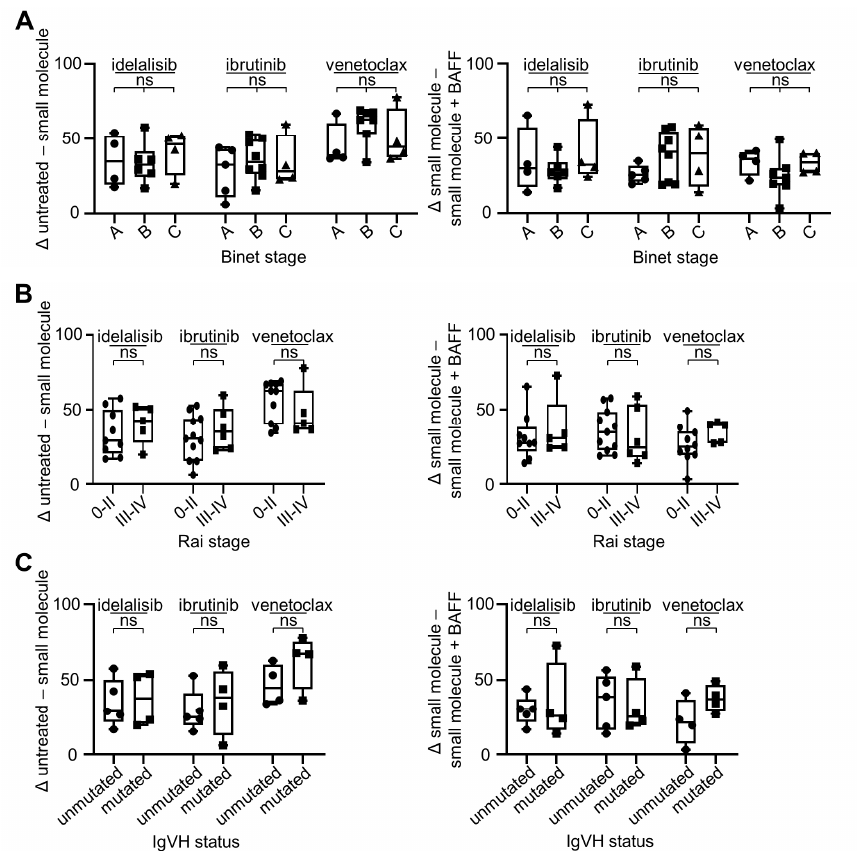
Figure 2. Clinical Binet stage, Rai stage and IgVH mutational status do not impact response to small molecule inhibitor treatment or survival-promoting effects of BAFF . PBMC from different CLL patients were exposed to idelalisib (500 nM), ibrutinib (500 nM) or venetoclax (2 nM) in the presence or absence of rhBAFF (500 ng/mL) and cell viability was determined by CTG assays. Results were normalized to the respective untreated samples and relative viability was calculated. The difference between the untreated sample and the small molecule inhibitor-treated sample (left side) and the difference between the respective small molecule inhibitor-treated sample alone and in combination with rhBAFF (right side) were analyzed. Results are depicted according to the clinical Binet stage ( A ), Rai stage ( B ) and IgVH mutational status ( C ). For statistical analyses, ordinary one-way ANOVA with Tukey’s multiple comparisons tests were performed in ( A , left) for idelalisib (A vs. B p = 0.9766, A vs. C p = 0.8850, B vs. C p = 0.7557) and ibrutinib (A vs. B p = 0.7739, A vs. C p = 0.5810, B vs. C p = 0.9138), and a Kruskal-Wallis test with Dunn’s multiple comparisons test for venetoclax (A vs. B p = 0.8564, A vs. C p = 0.9279, B vs. C p > 0.9999) (idelalisib: Binet A n = 4, Binet B n = 5, Binet C n = 5; ibrutinib: Binet A n = 5, Binet B n = 7, Binet C n = 5; venetoclax: Binet A n = 4, Binet B n = 6, Binet C n = 5). In ( A , right), a Kruskal-Wallis with Dunn’s multiple comparisons test was used for idelalisib (A vs. B p > 0.9999, A vs. C p > 0.9999, B vs. C p > 0.9999), and ordinary one-way ANOVA with Tukey’s multiple comparisons test for ibrutinib (A vs. B p = 0.4560, A vs. C p = 0.3997, B vs. C p = 0.9753) and venetoclax (A vs. B p = 0.5154, A vs. C p = 0.9090, B vs. C p = 0.7447). In ( B , left), unpaired two-tailed t -tests were used for idelalisib (0-II vs. III-IV p = 0.4797) and ibrutinib (0-II vs. III-IV p = 0.4288), and for venetoclax a two-tailed Mann-Whitney test (0-II vs. III-IV p = 0.4396) (idelalisib: Rai 0-II n = 9, Rai III-IV n = 5; ibrutinib Rai 0-II n = 11, Rai III-IV n = 6; venetoclax Rai 0-II n = 10, Rai III-IV n = 5). In ( B , right), a two-tailed Mann-Whitney test was used for idelalisib (0-II vs. III-IV p = 0.7972) and venetoclax (0-II vs. III-IV p = 0.0992), and an unpaired two-tailed t -test was performed for ibrutinib (0-II vs. III-IV p = 0.6485). In ( C ), unpaired two-tailed t -tests were used for idelalisib (left: unmutated vs. mutated p = 0.8180, right: unmutated vs. mutated p = 0.7128), ibrutinib (left: unmutated vs. mutated p = 0.6248, right: unmutated vs. mutated p = 0.8103) and venetoclax (left: unmutated vs.